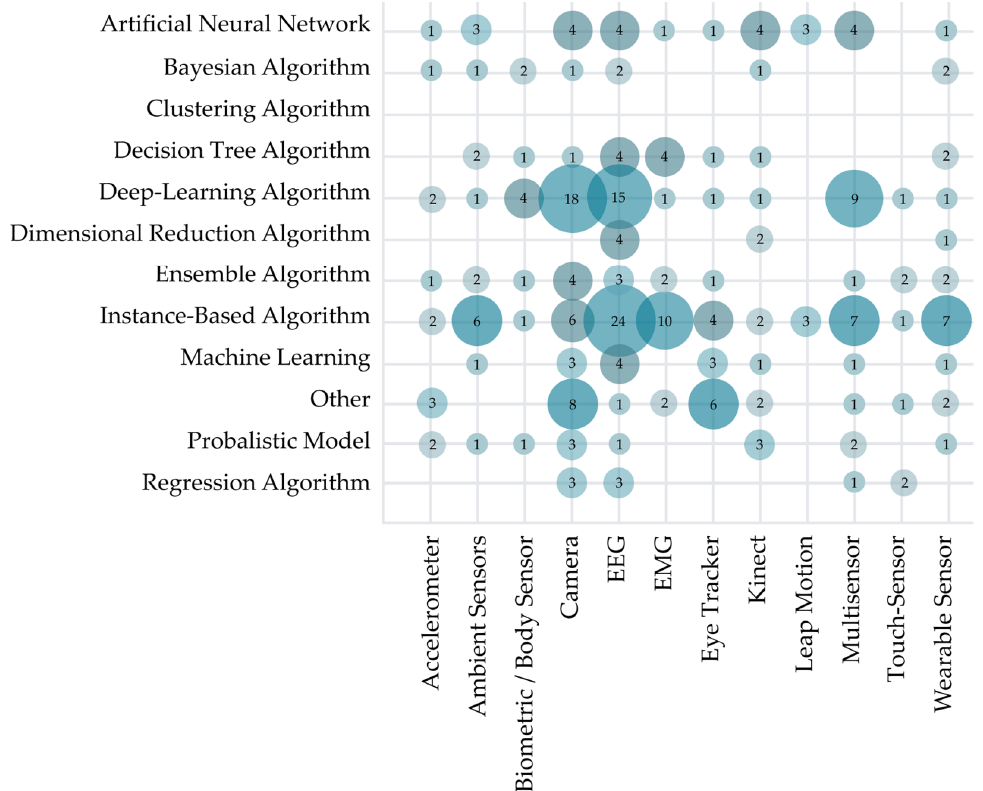
Figure 19. Distribution of sensors used in AI methods and algorithms.